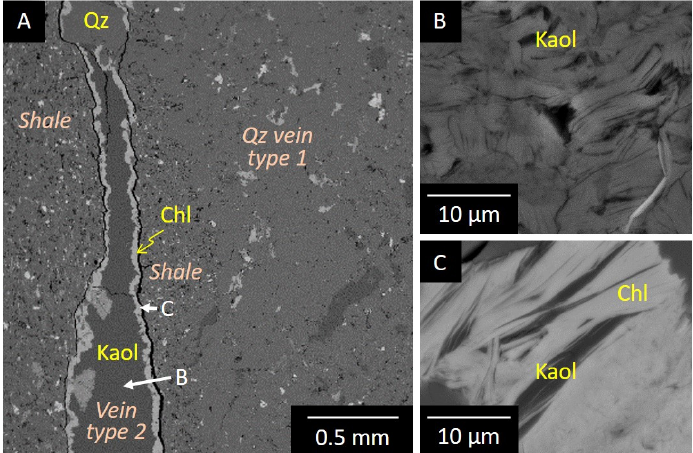
Figure 6. SEM images (backscattered-electrons) of veins/shale contacts. ( A ): On the left of the image, a vein mainly filled by kaolinite–type 2, and surrounded by a chlorite fringe. On the right, a vein mainly filled by quartz–type 1, not presenting chlorite fringe at the contact of the shale in absence of kaolinite/shale contacts. ( B , C ) images are located. B: platy crystals of kaolinite. C: kaolinite/chlorite intergrowths. Qz: quartz; Kaol: kaolinite; Chl: